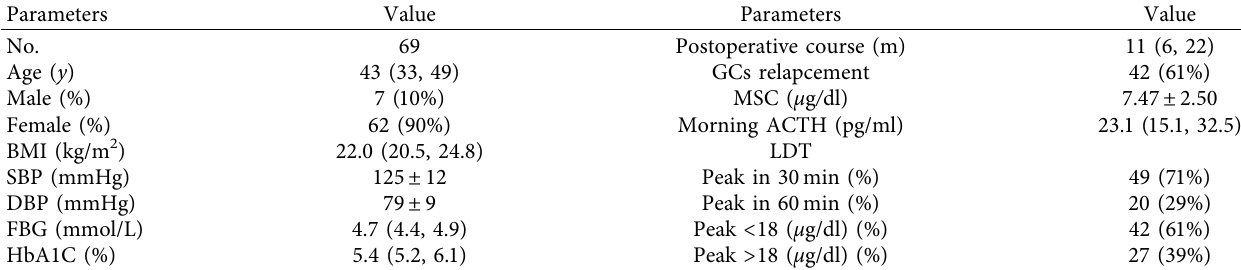
Table 1: Characteristics of the patients included in the study.